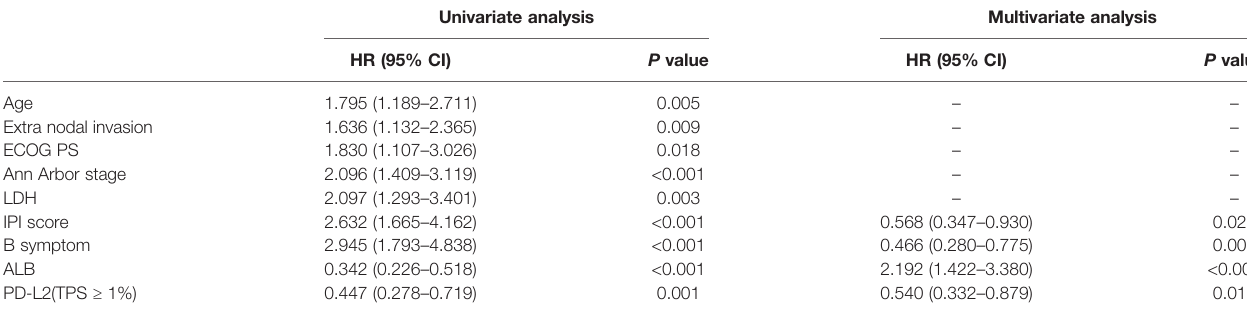
TABLE 4 | Univariate and multivariate analyses of clinicopathological factors associated with progression free survival in DLBCL